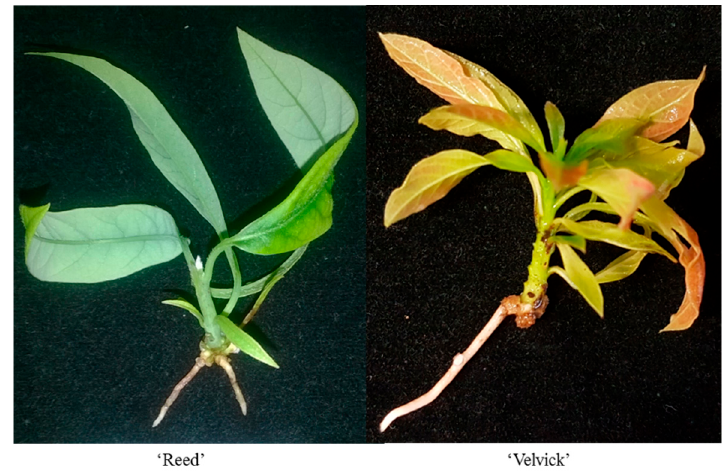
Figure 10. Differences in size of roots of the two different rootstocks, thin roots of easy-to-root ‘Reed’ and plump root of difficult-to-root ‘Velvick’.